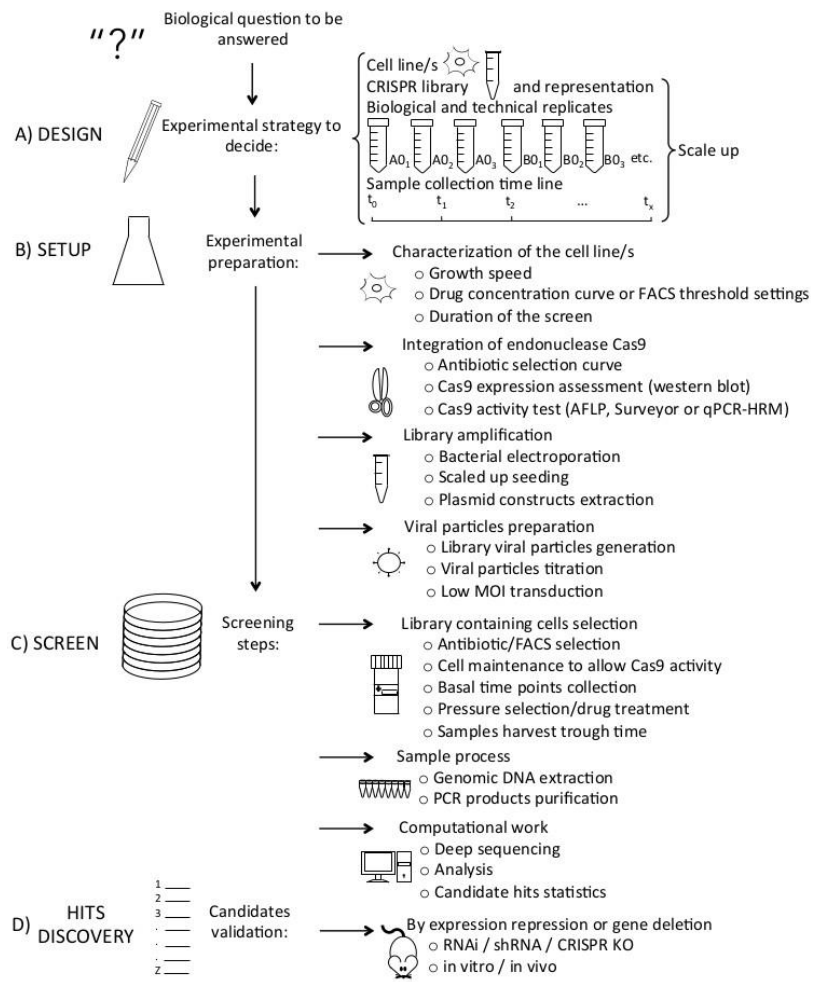
Figure 1. Schematic outline of CRISPR/Cas genome-wide screens. ( A ) Previous to the screen, the experimental design must fit the biological question to solve. The experimental strategy includes selection of cell line/s, CRISPR library and its representation, number of biological and technical replicates and the total amount of samples to harvest, all together will dictate cell quantity and number of plates to culture. ( B ) Before starting the actual experiment, a setup preparation takes place: characterization of the cell line/s, integration of the endonuclease Cas9, library amplification, viral particles preparation and cell transduction. ( C ) The screening steps are: selection of the transduced cells, collection of the basal samples, drug treatment or pressure selection, samples harvest, DNA extraction, PCR amplification, NGS, computational analysis and candidate compilation. ( D ) For candidate hits validation, gene expression may be repressed by RNAi or shRNA or genes may be deleted using CRISPR KO, in vitro and in